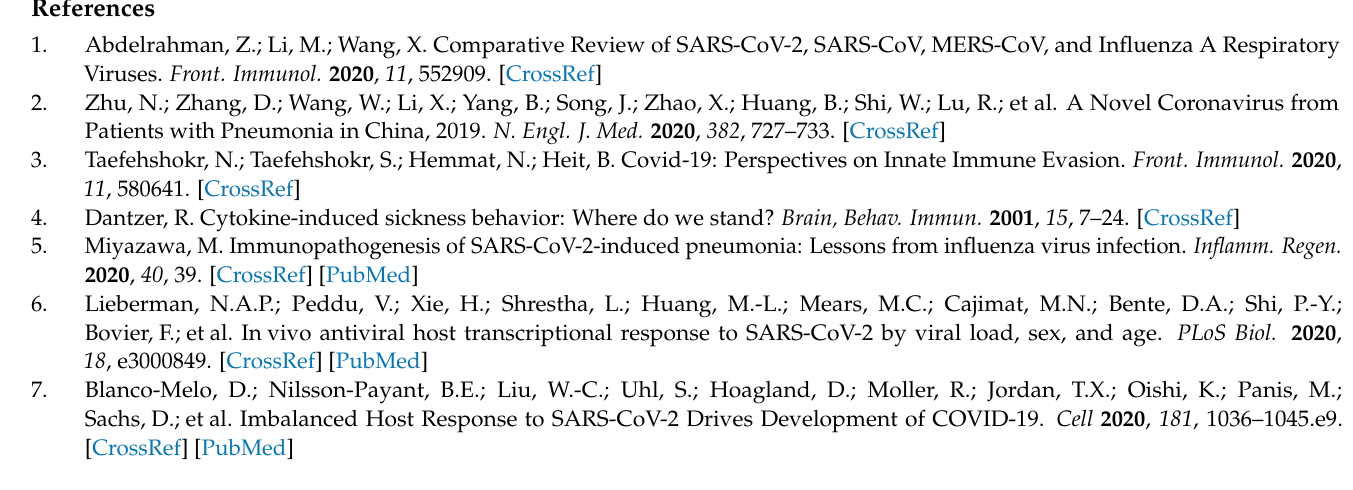
tRNA, Figure S4: Metagene coverage aligned to the start codon of all annotated protein coding genes, Table S1: RNA-seq differential expression, Table S2: Ribo-seq differential expression, Table S3: Riborex differential